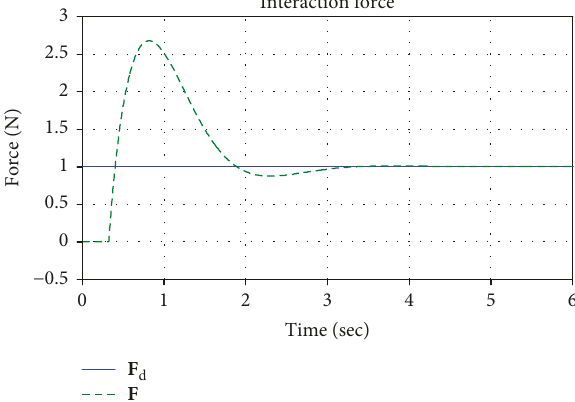
Figure 20: Desired and actual position of the end e ff ector in the body frame.